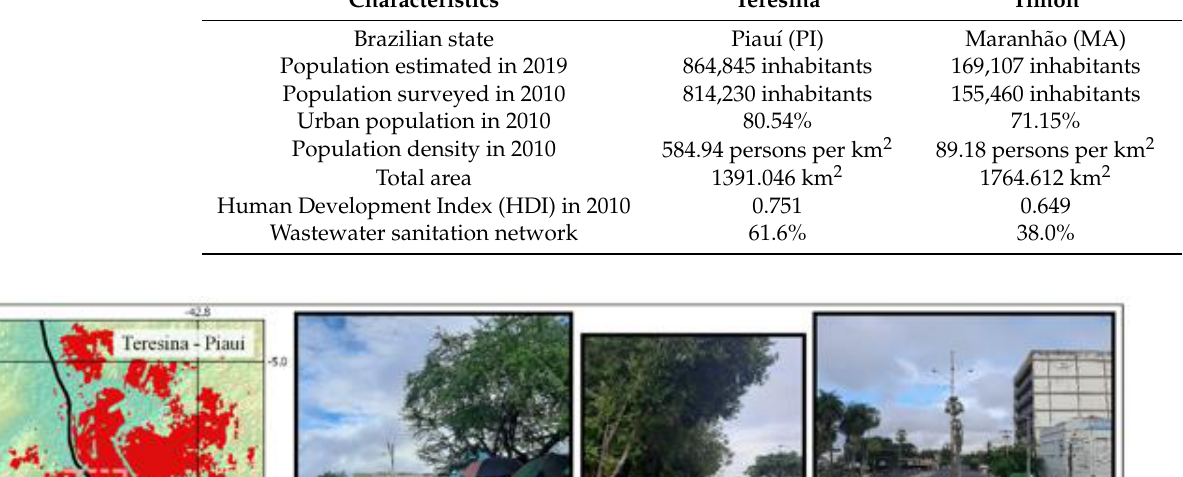
Table 1. Socioeconomic characterization of the Teresina-Timon conurbation area.